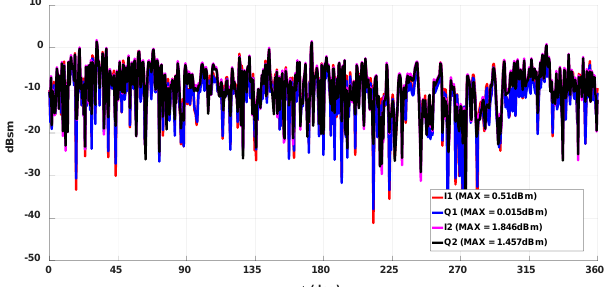
Figure 10. Human body: monostatic RCS results in near-field conditions.